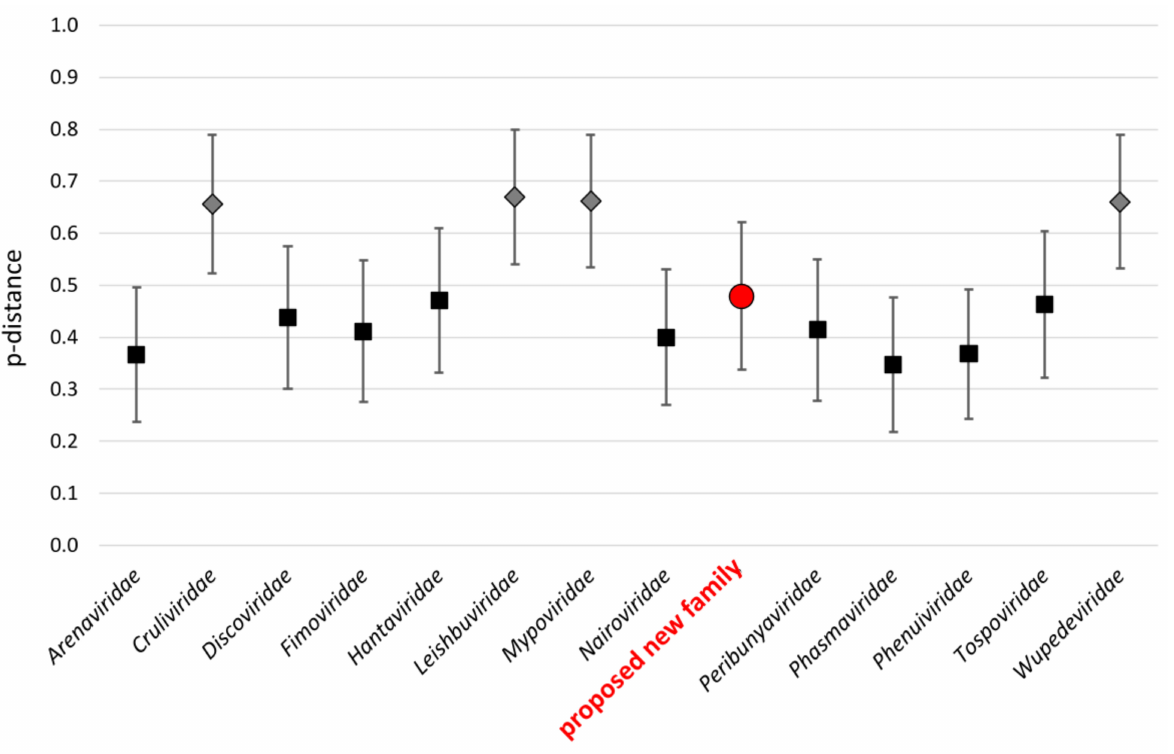
Figure 6. Mean evolutionary p -distances between Bunyavirales families. Families for which one sequence was used in the analysis are represented by a gray diamond, and families for which >1 sequences were included are represented by a black square. The proposed new family is highlighted by a red circle.